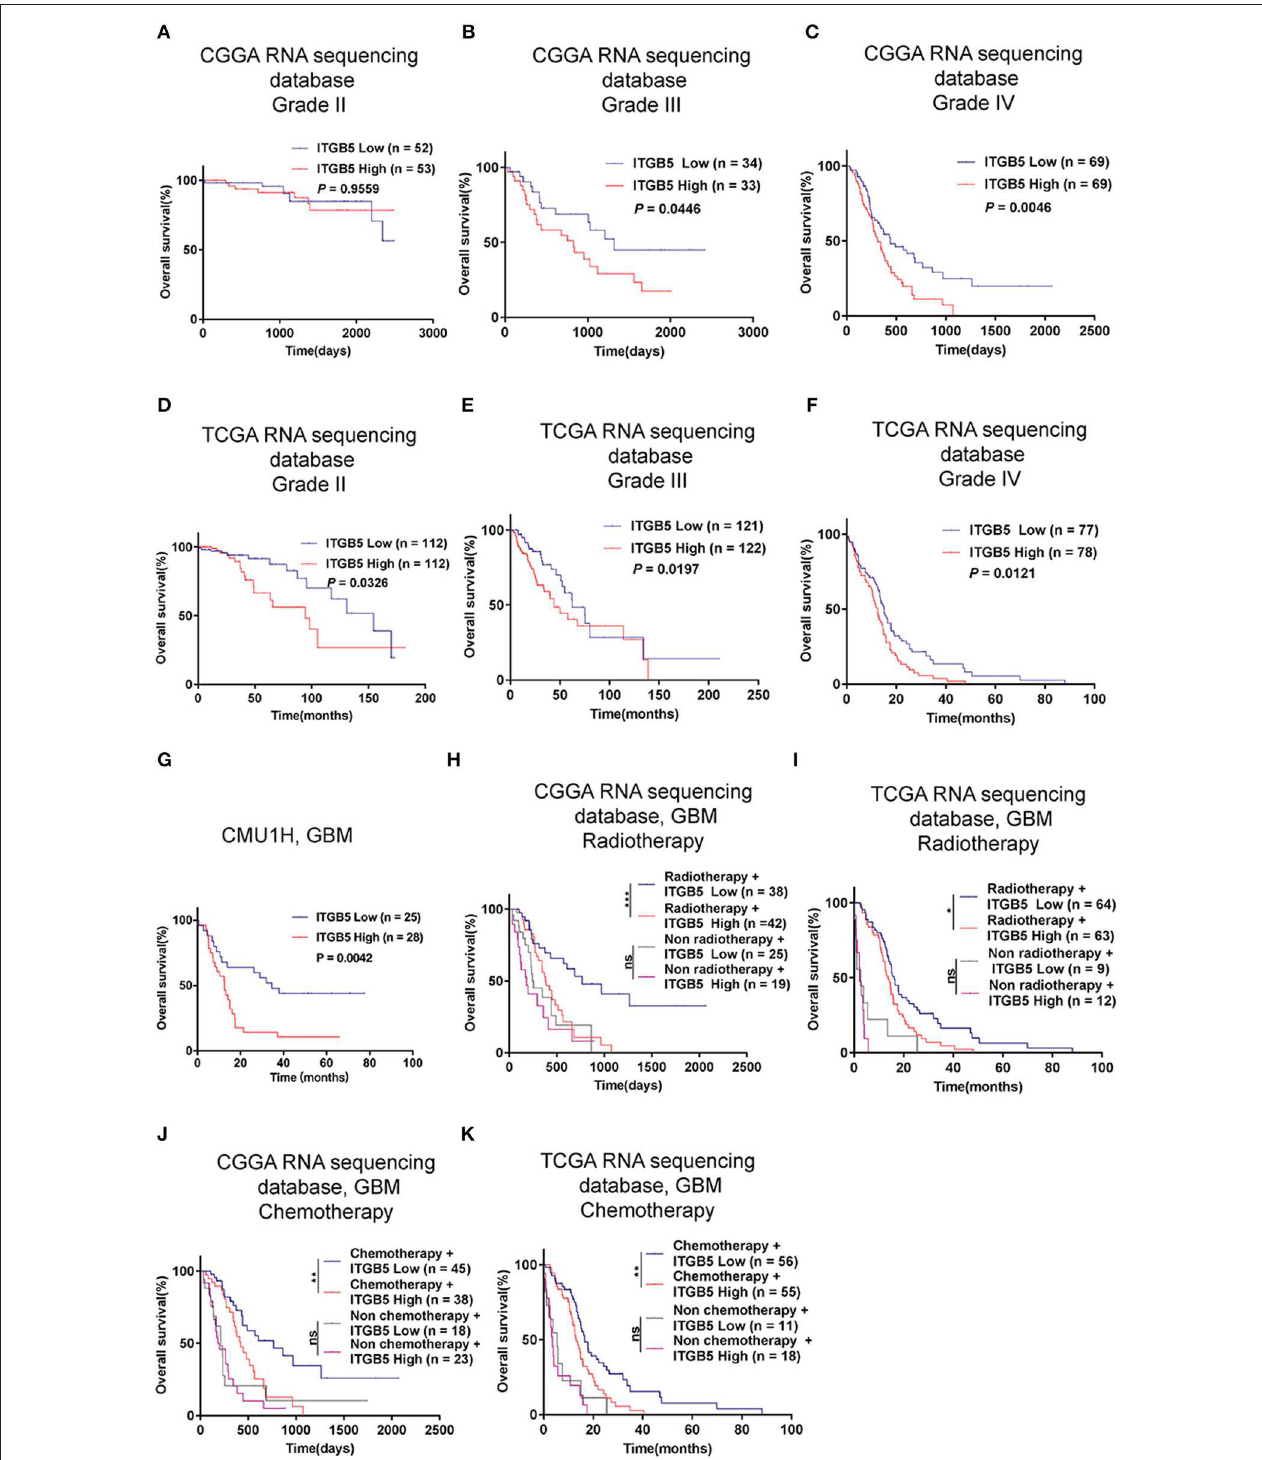
FIGURE 3 | ITGB5 overexpression is a prognostic biomarker in GBM. (A–F) , Kaplan-Meier analysis of the association between ITGB5 expression and patient survival according to glioma grade ( A , CGGA grade II; B , CGGA grade III; C , CGGA grade IV; D , TCGA grade II; E , TCGA grade III; F , TCGA grade IV). (G) Kaplan-Meier analysis of the correlation between high ITGB5 expression and patient prognosis in GBM (ITGB5 high vs. low, P = 0.0042; log-rank test). (H–K) Results of the Kaplan-Meier analysis demonstrating that high ITGB5 expression is associated with poor survival in GBM patients receiving radiotherapy ( H , CGGA RNAseq; I , TCGA RNAseq) or chemotherapy ( J , CGGA RNAseq; K , TCGA RNAseq). ns, P > 0.05; * P < 0.05; ** P < 0.01; *** P < 0.001 (log-rank test).